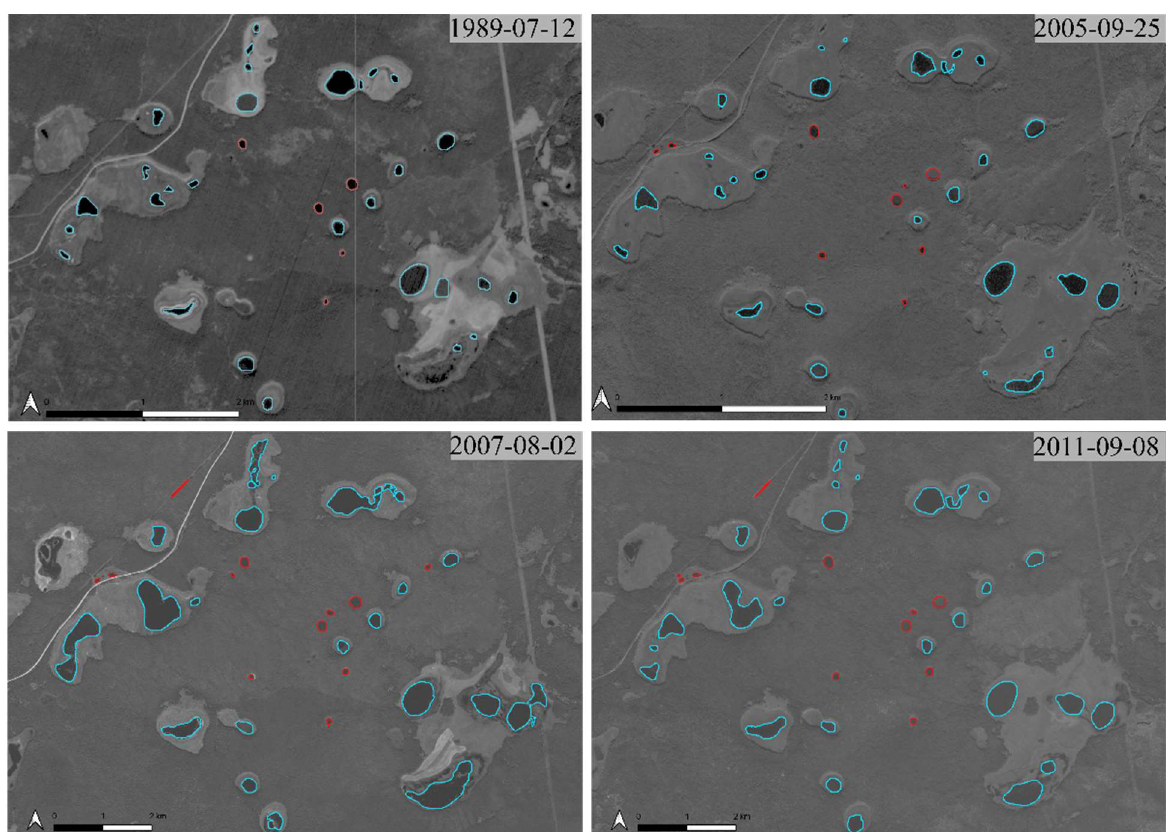
Figure 14. Comparison between the 12 July 1989 image, 25 September 2005 image, 2 August 2007 image and 8 September 2011 images. UCA lakes are outlined in blue. RT lakes are outlined in red. Lakes outside of the ~35 lakes discussed in the text are not outlined.